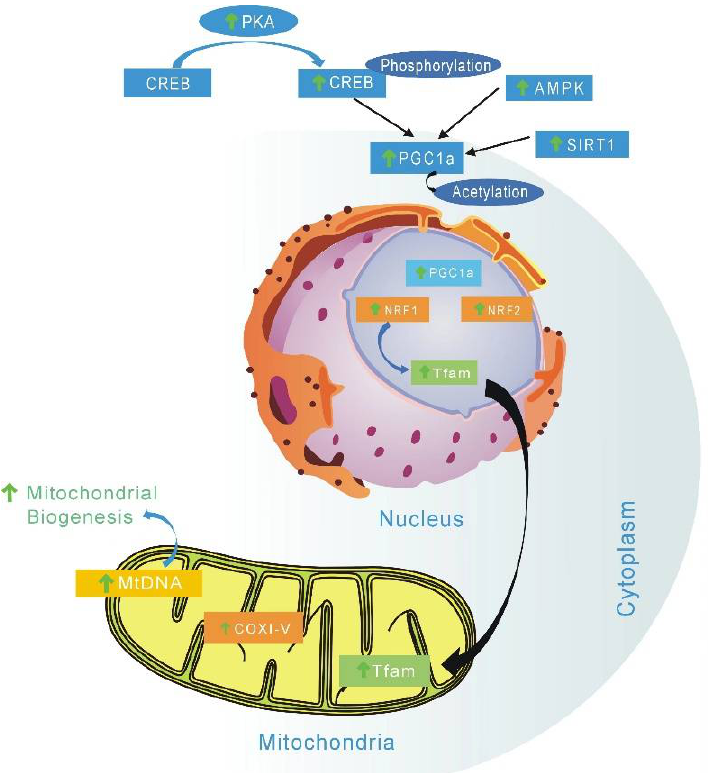
Figure 2. Possible metabolic mechanism stimulated by catechins to activate mitochondrial biogenesis. EGCG can increase mitochondrial biogenesis by enhancing expression of complex I, II, V, and PGC-1α. Catechins can also induce mitochondrial biogenesis by regulating critical regulators (PGC-1α, p-AMPK, SIRT1). TFAM—Mitochondrial transcription factor A; COI-V—Oxidative phosphorylation complexes I to V; mtDNA—mitochondrial DNA; NRF1/2—nuclear respiratory factors 1 and 2; PGC1α—peroxisome proliferator-activated receptor gamma coactivator 1α; SIRT1—Sirtuin 1; AMPK—AMP protein kinase; CREB—cyclic AMP response element binding protein; PKA—Protein Kinase A; ↑ , vertical arrow indicates catechin induction effects.